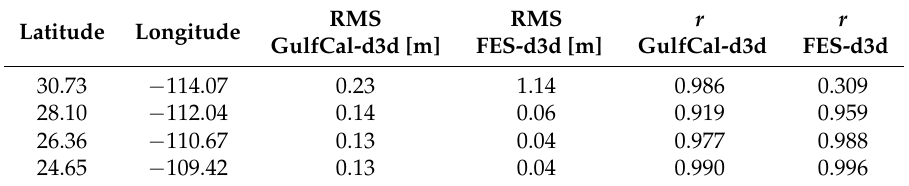
Table 1. Root mean square error (RMS) of sea surface height from GulfCal versus Delft3d, FES14 versus Delft3d, and the respective Pearson correlation coefficients, over the simulation period. The Pearson p are effectively zero for all cases. The first 250 h of the simulation were discarded to remove the spin-up. Latitude